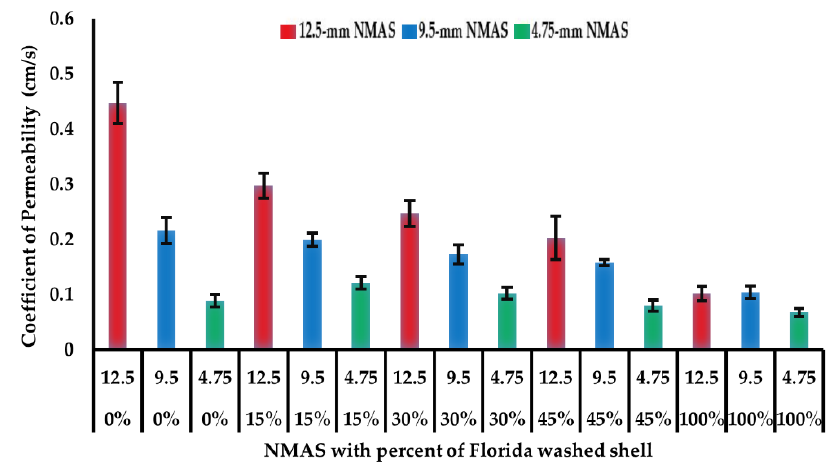
Figure 6. Permeability results of open-graded asphalt mixtures.